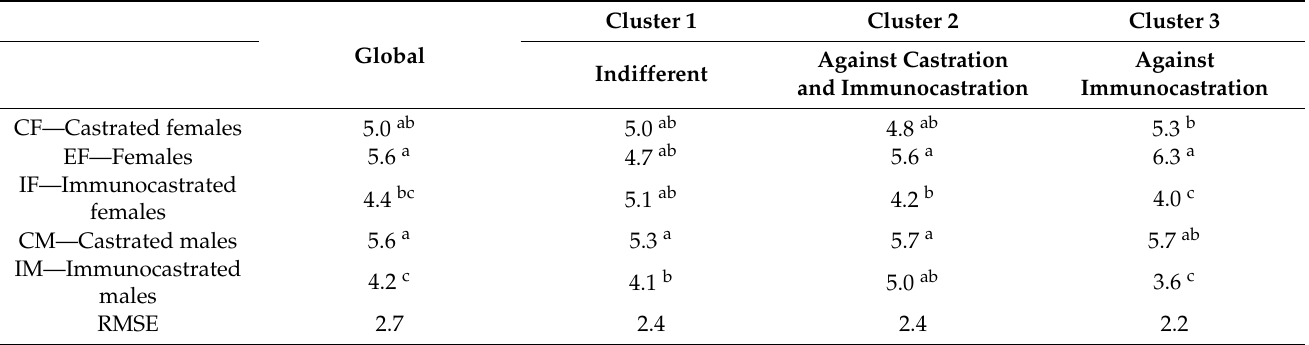
considering all the consumers as a pool and by cluster (assessed in a linear scale from 0:’ Sure that I will not buy it’ to 10: ‘Sure I will buy